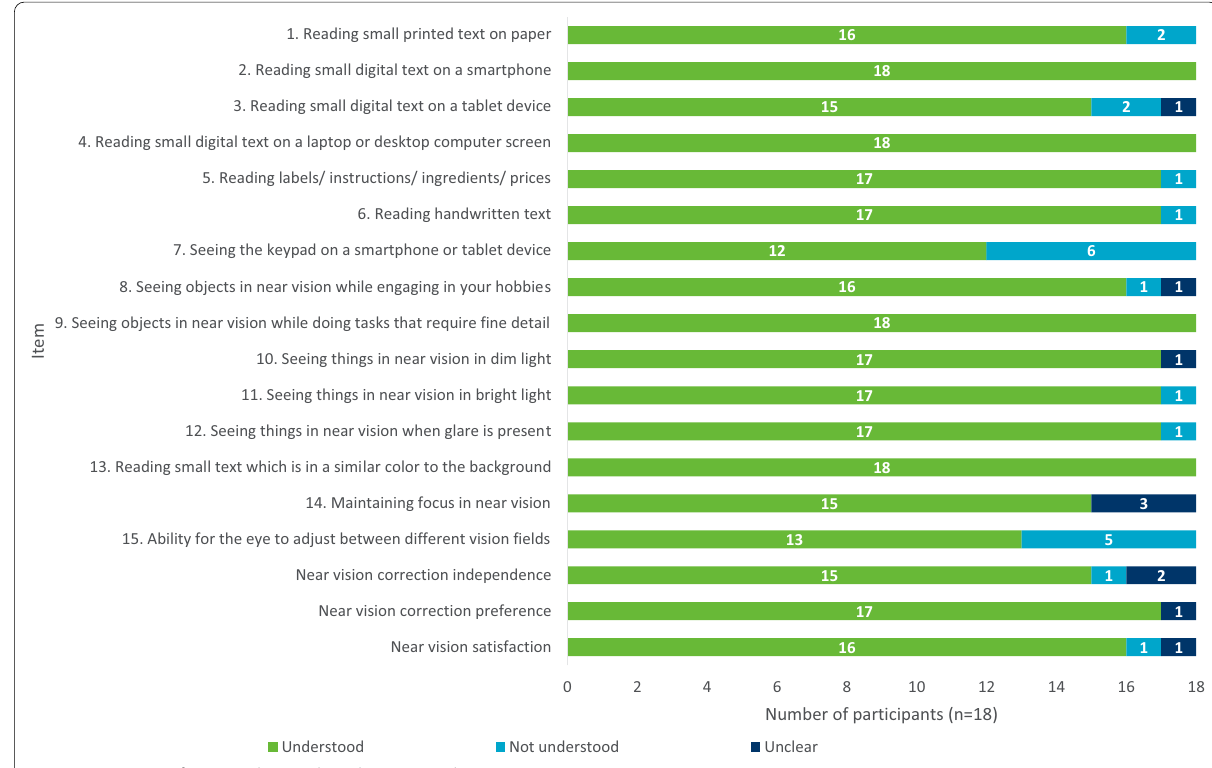
Fig. 4 Summary of item understanding during round 2 CD